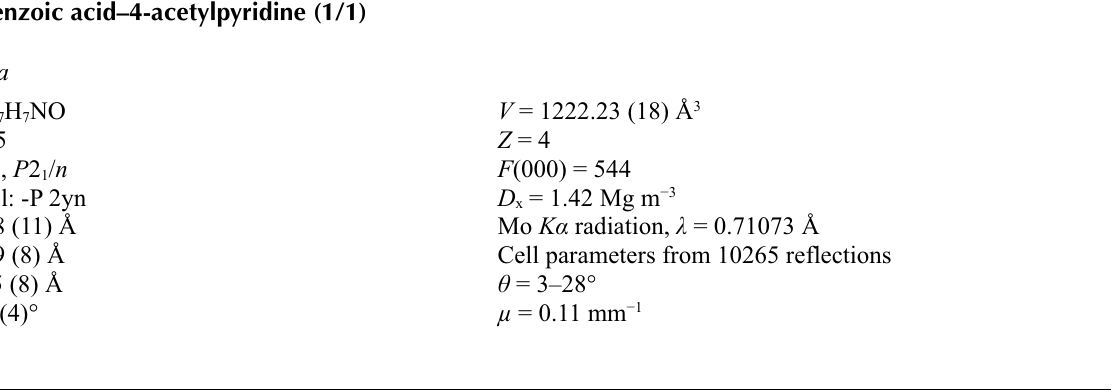
Packing view to illustrate the offset from planarity of the various units. This figure shows exactly the same molecules as in Fig. 2, but rotated by